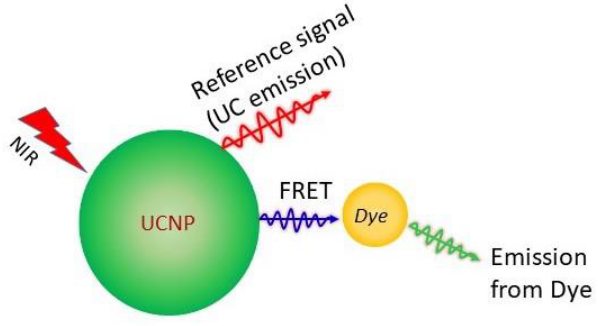
Figure 1. Schematic representation of upconversion sensitized pH-sensor. The pH-sensitive dye emission is analyzed with respect to the UC emission. The Förster resonance energy transfer (FRET) from UCNP to the pH-sensitive dye is shown.